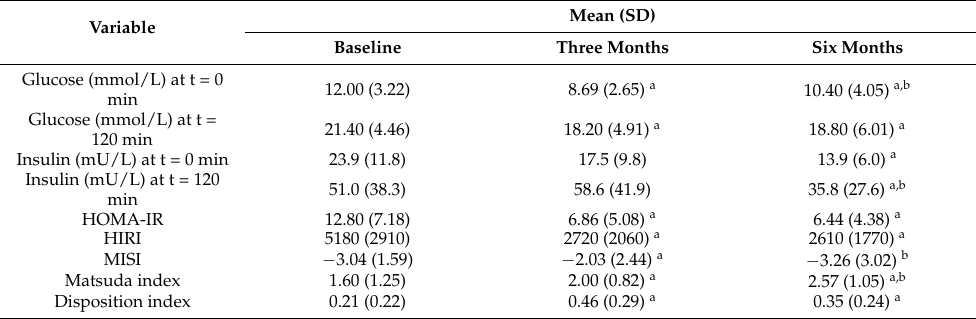
Table 4. Changes in oral glucose tolerance test (OGTT) response between baseline, three months, and six months of intervention.